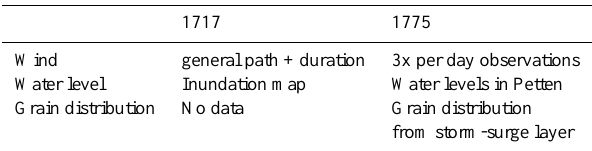
Table 2. Overview of available data per